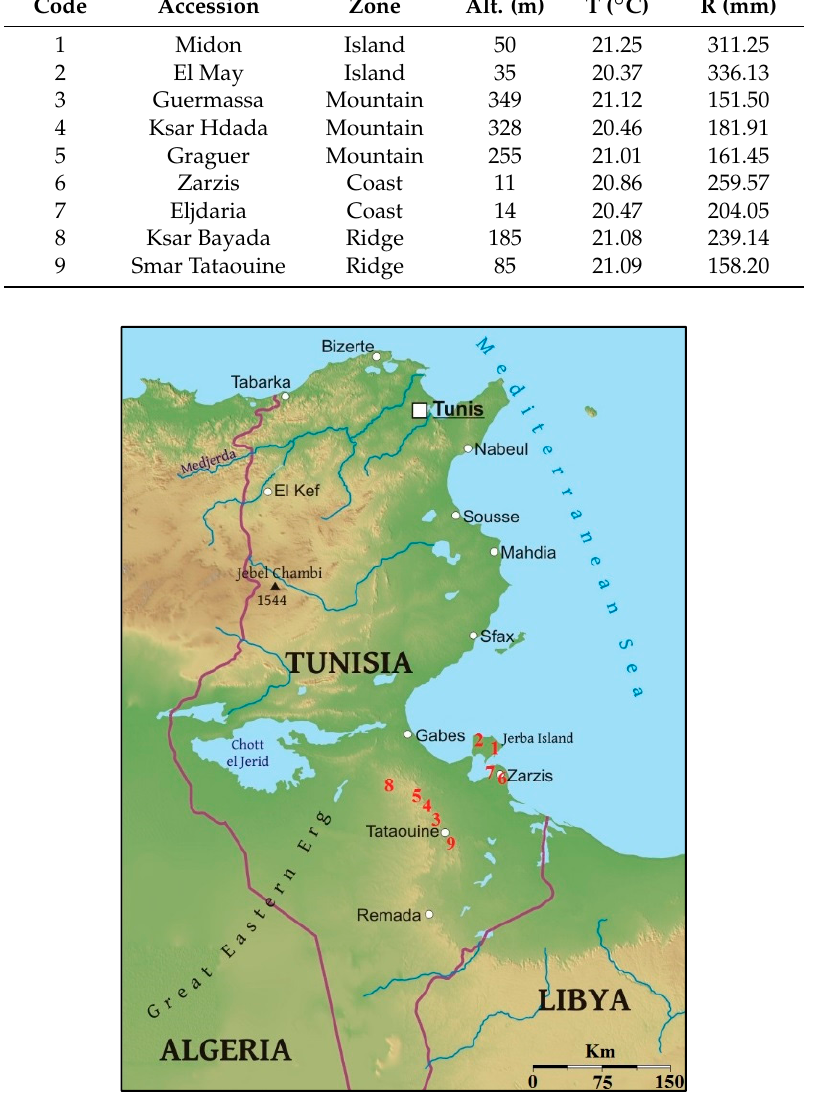
Figure 5. Location of the collection place of the nine accessions of “Ardhaoui” barley landraces evaluated.